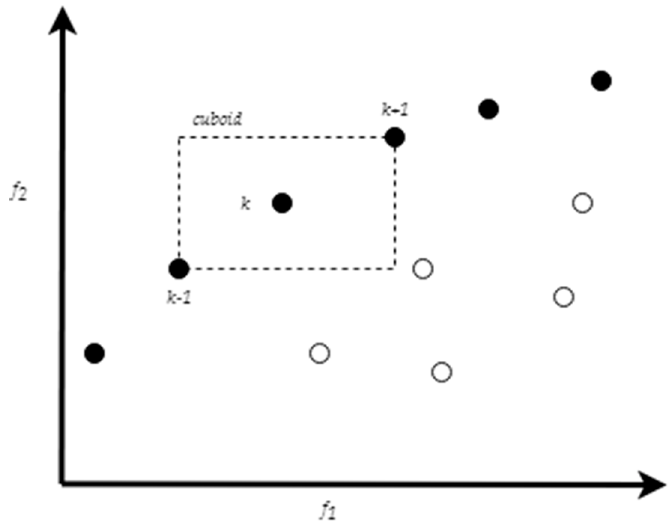
Figure 5. The crowding distance of individual in the front. Amended from Ref. [17].